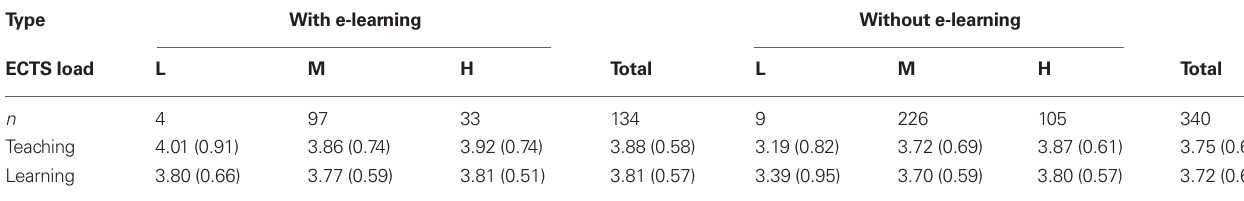
Table 2 | Mean values for the TLP according to use of e-learning and performance level.